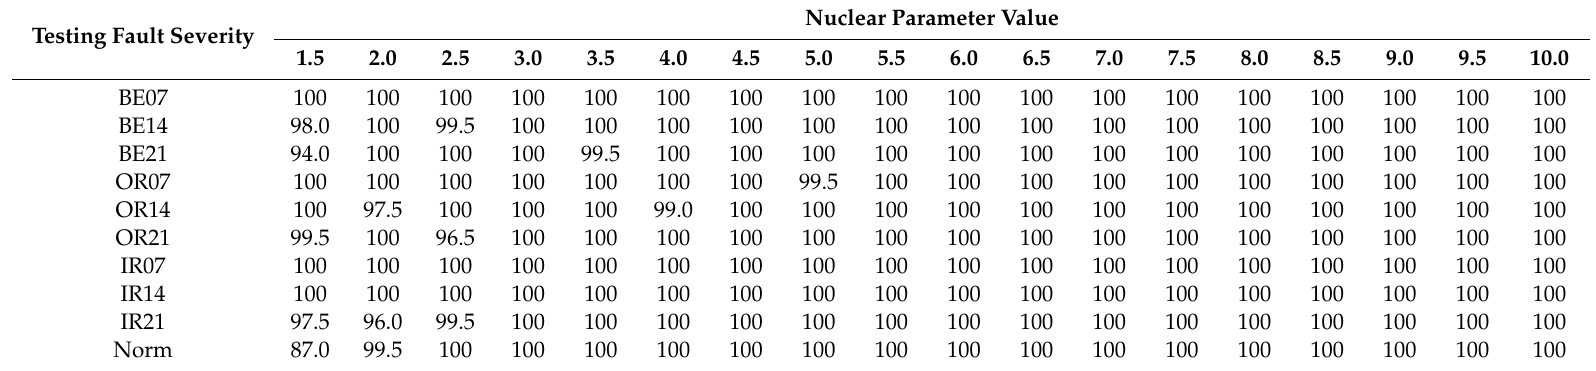
Table 17. The influence of nuclear parameter selection of the mRVM 2 _conv A on fault identification accuracy of the rolling bearing (%). Testing Fault Severity